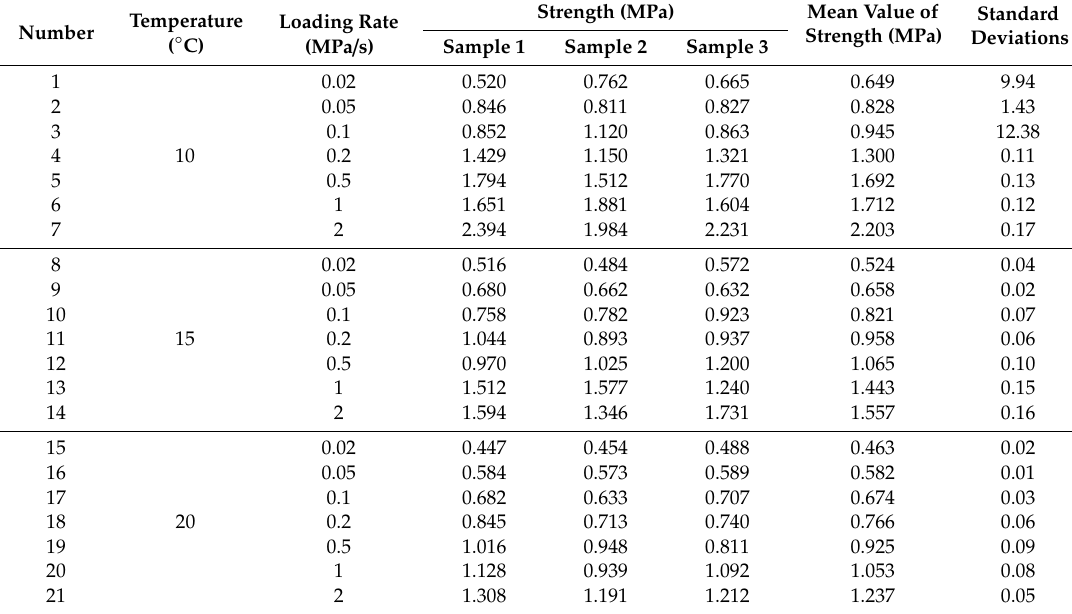
Table 6. The rubber asphalt mixture strength